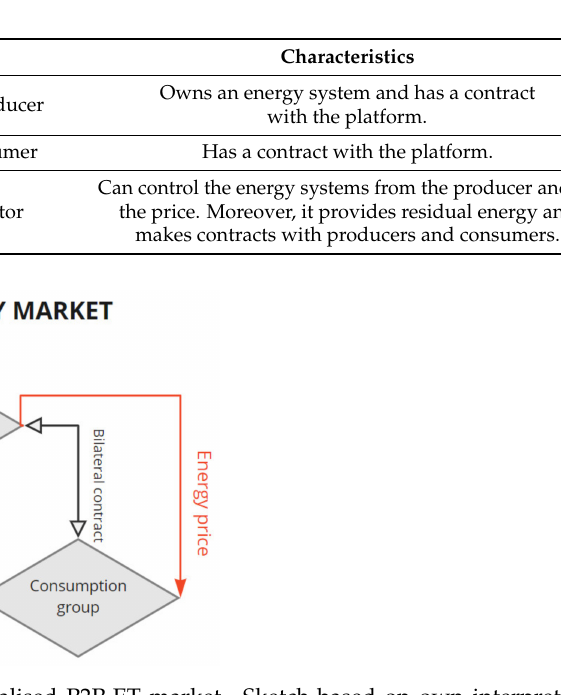
Figure 3. Actor roles sketch—centralised P2P-ET market. Sketch-based on own interpretation from Section